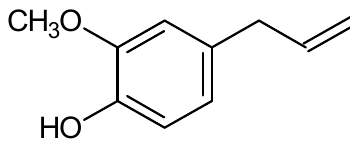
Figure 3. Chemical structure of eugenol. HOCH 3